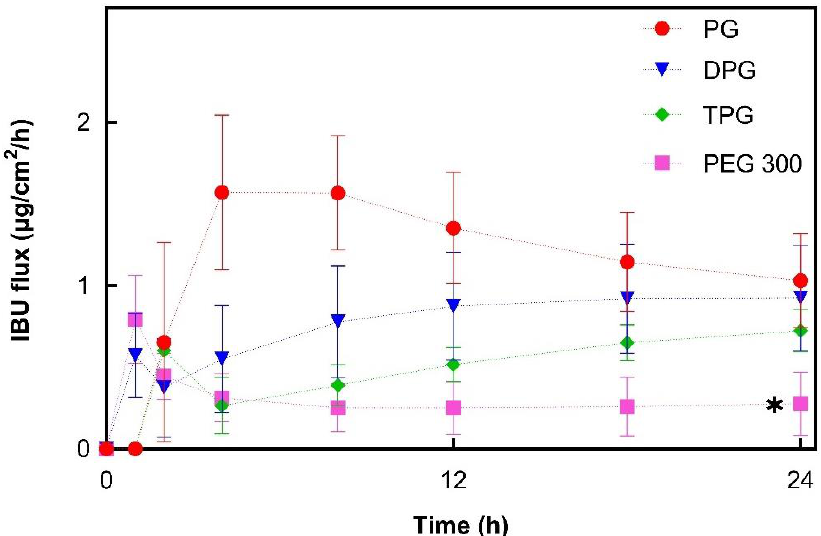
Figure 3. Estimated flux profiles of IBU through human epidermis after application of 5% IBU samples (mean ± SD; 5 ≤ n ≤ 6, * p < 0.05).